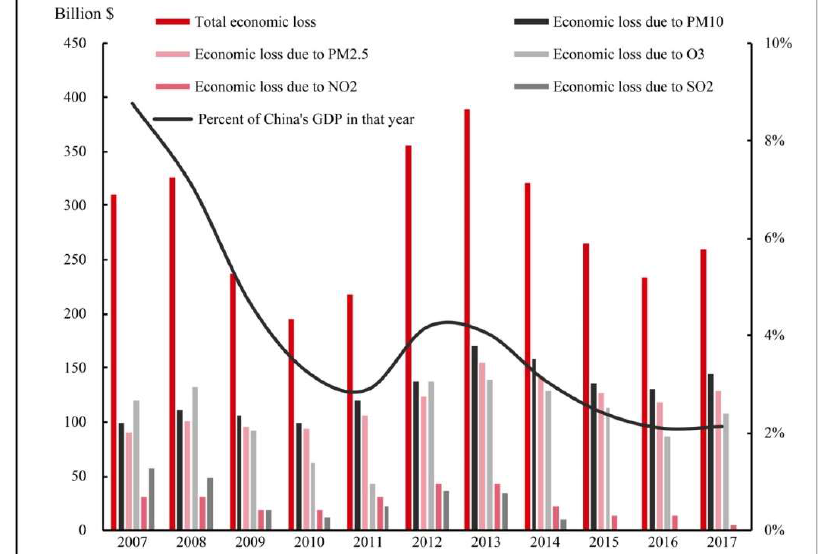
Figure 5. Historical change of overall health economic losses caused by ambient pollutants in China.